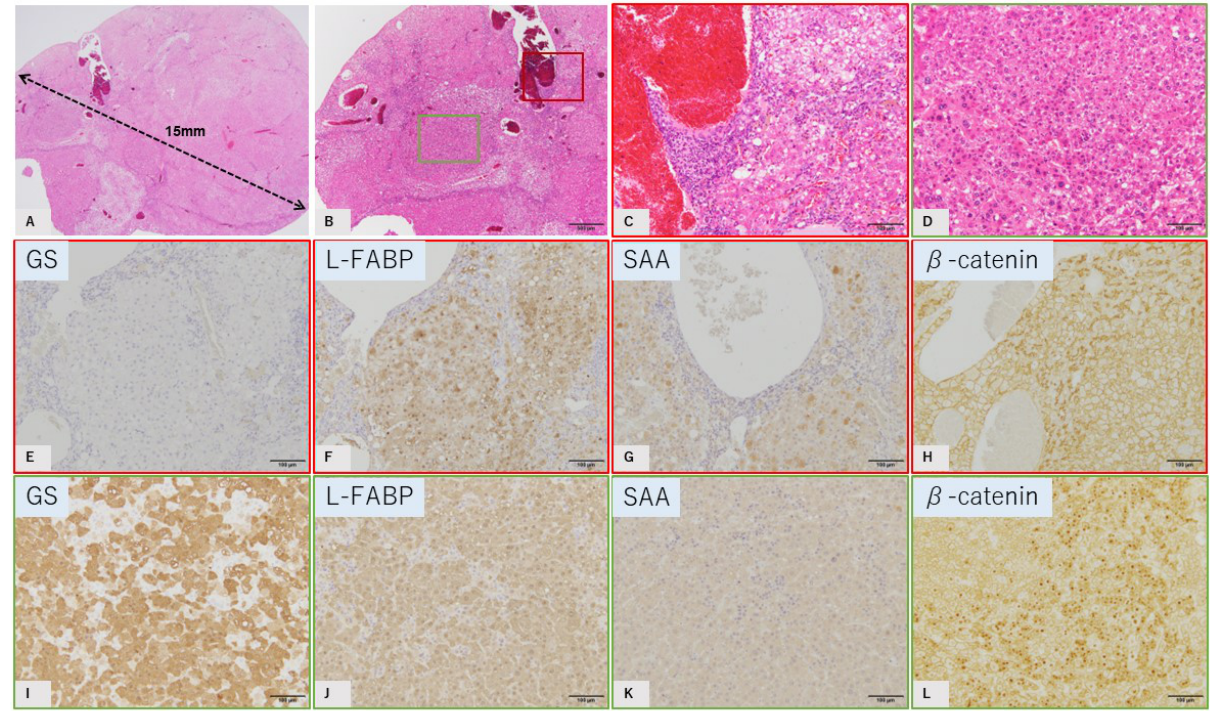
Figure 5. GS-negative tumor mimics of b-catenin-activated IHCA (b-IHCA) (tumor 6). HE staining ( A – D ). Immunostaining of lesions seen in C ( E – H ) and D ( I – L ), which are indicated by the colored boxes in ( B ). Immunostaining of GS ( E , I ), L-FABP ( F , J ), SAA ( G , K ), and b-catenin ( H , L ). ( A , B ): Tumor diameter is 15 mm and various histological patterns are seen. Most of the tumor has a trabecular pattern of hepatocytes with minimal atypia and sinusoidal dilatation, with some small atypical foci of diameter 2 mm. ( C ): Representative image of the main part of the tumor (higher magnification of the red box in ( B )). ( D ): Representative image of atypical foci (higher magnification of the green box in ( B )). Immunostaining of GS: negative in ( E ) and diffuse positive in ( I ); L-FABP: positive in ( F , J ); SAA: no strong staining in ( G , K ); b-catenin: membranous staining in ( H ), nuclear staining in ( L ). Tumor diameter is 15 mm ( A ) (scale: B , 500 μm; C –L, 100 μm).